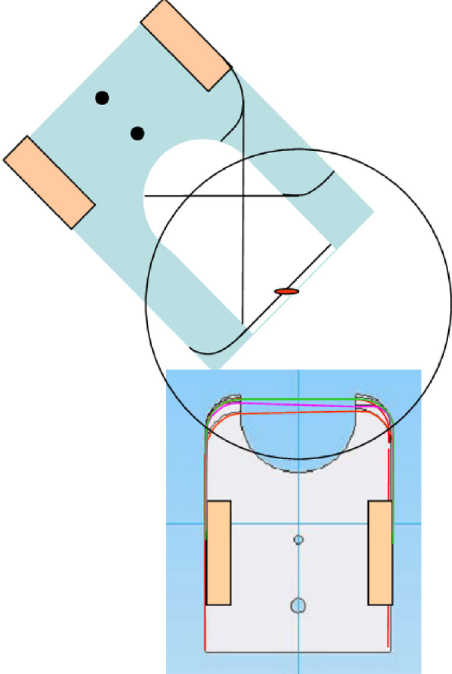
FIG. 1. Schematic of wire scanners installed behind the IP of ATF2.